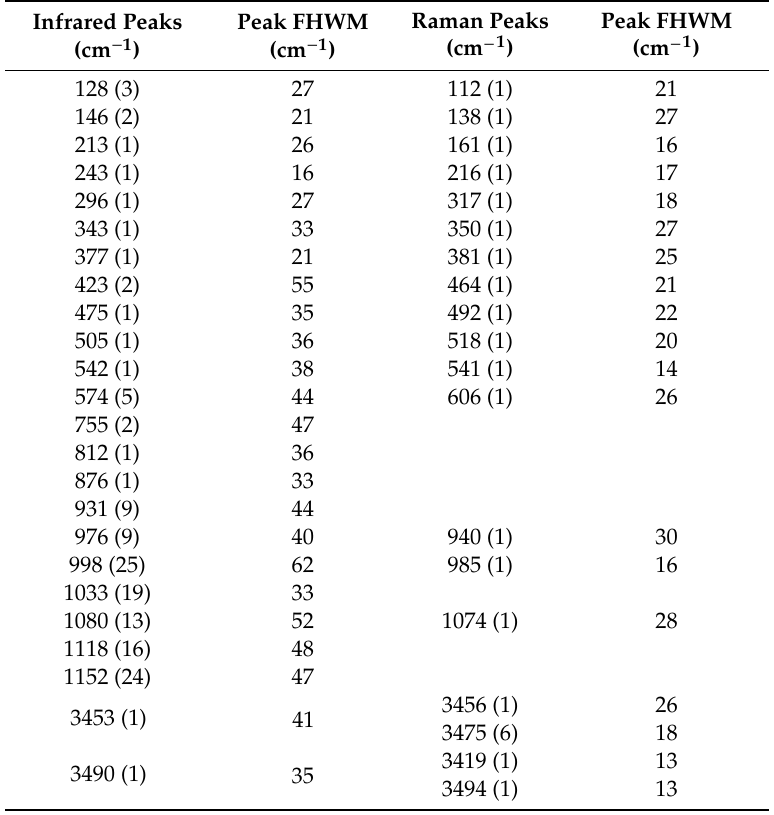
Table 1. Central energy values and frequency half width maximum (FHWM) values for principle Gaussian functions, comprising the fitted infrared and Raman